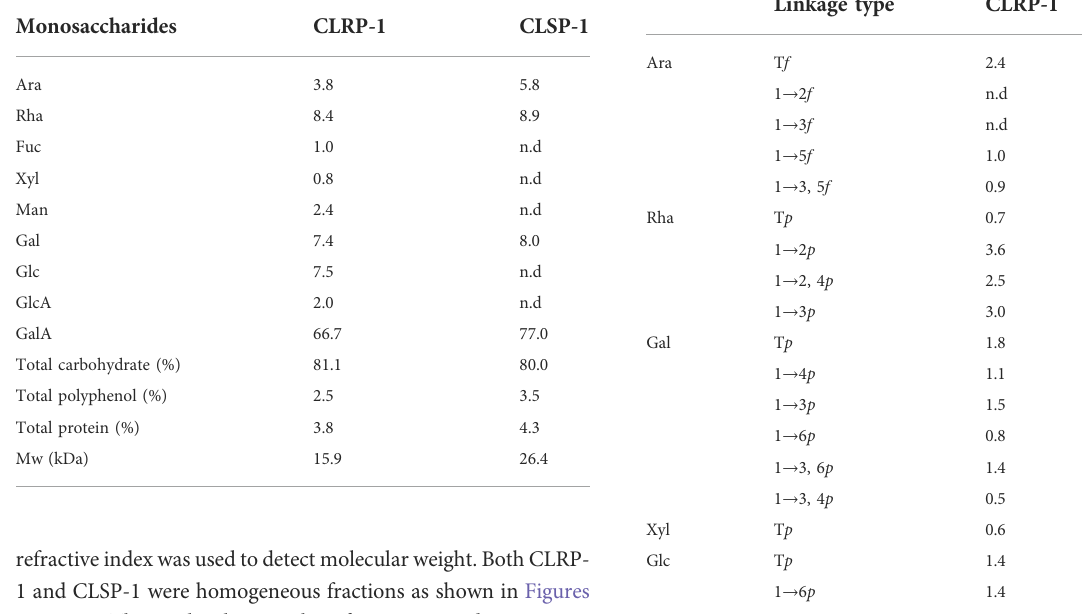
TABLE 1 Monosaccharide compositions (mol%) and Mw of polysaccharide fraction from the different plant parts of C.